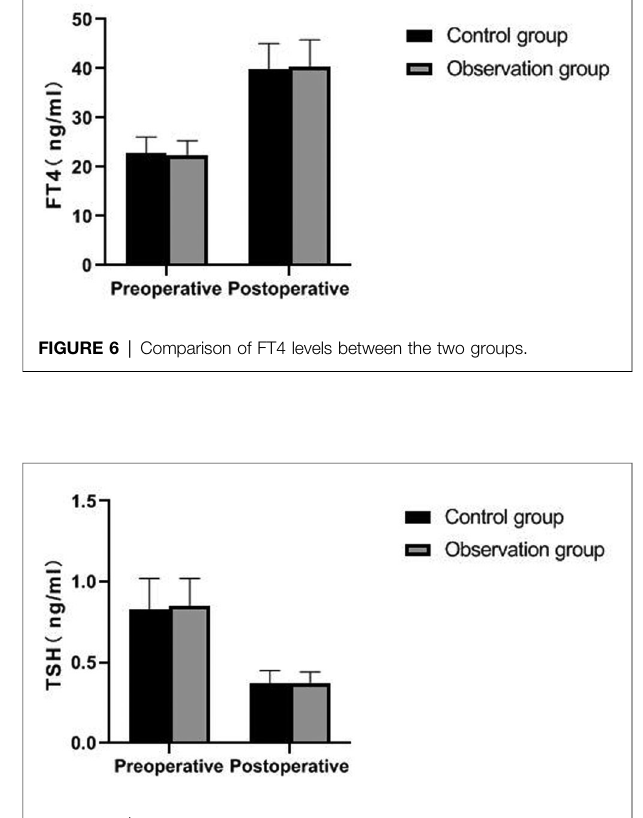
FIGURE 7 | Comparison of TSH levels between the two